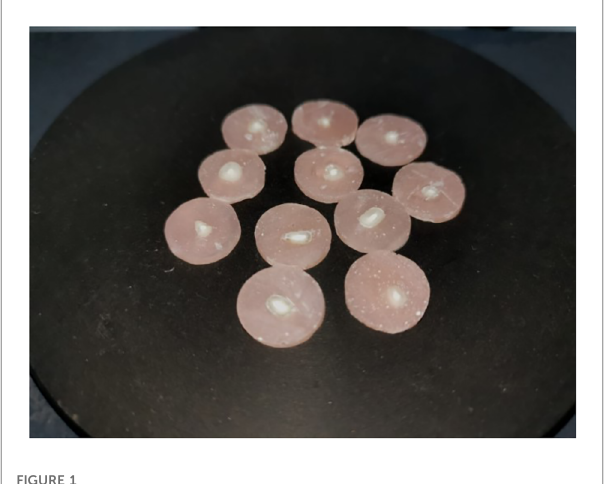
FIGURE 1 Dentin discs with root canal path before applying